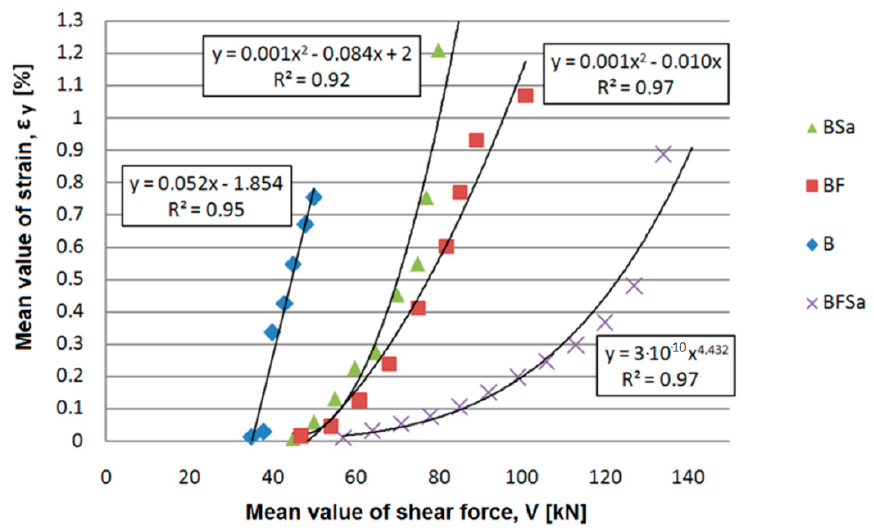
Figure 20. An example of dependence of the side surface strain at element height ( ε y ) on the transversal force ( V ) for B, BSa, and BF series beams at the first stage of the test.